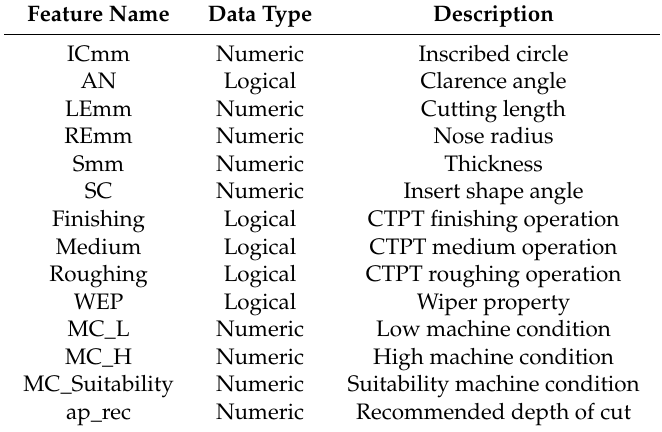
Table 1. Feed rate dataset–feature descriptions; CTPT: finishing, medium and roughing operations.